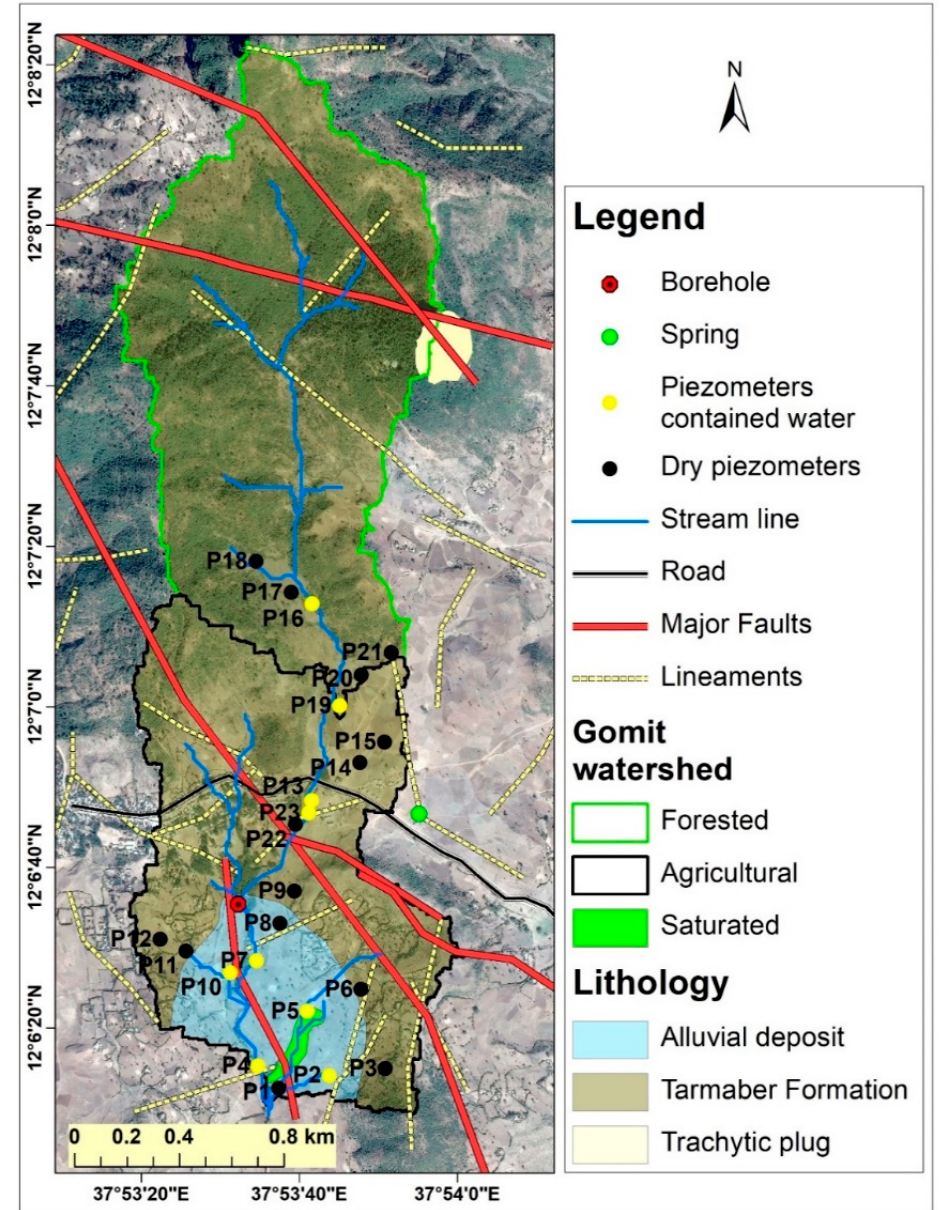
Figure 5. Map of the Gomit watershed with rain gauges, piezometers, spring, and borehole. The approximate locations of the major fault lines (red lines) and lineaments (yellow dashed lines) were identified by various methods. The yellow filled circles are the wells that contained water during the growing season.